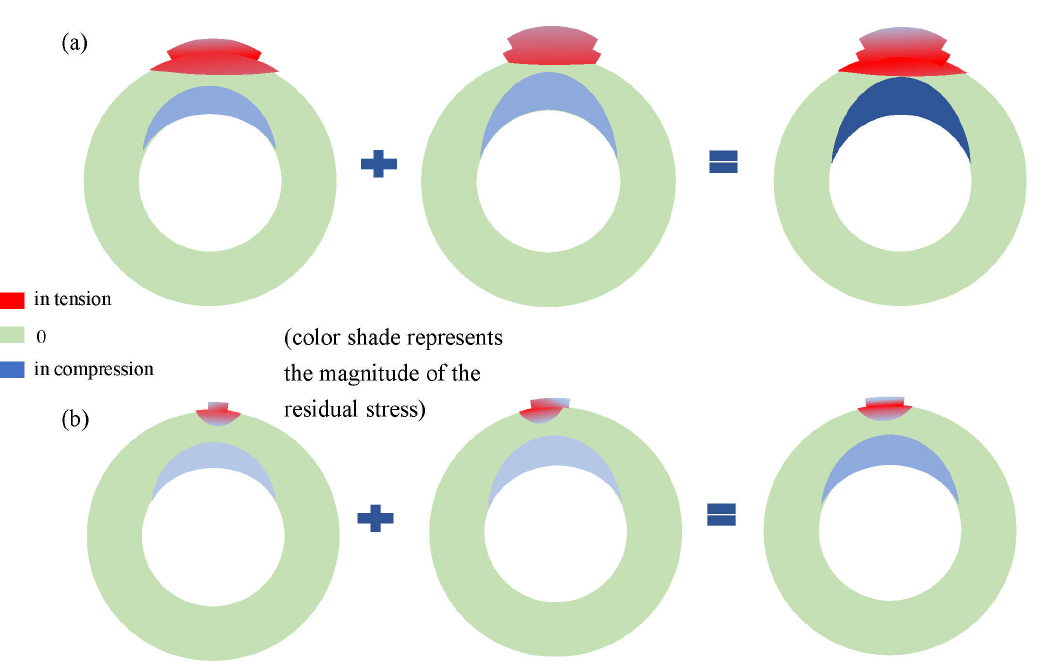
Figure 11. Hoop residual stress distribution at mid-length of the weld overlay joint with center-to-outside welding se- quence for ( a ) 1 layer, ( b ) 2 layers, and ( c ) 3 layers, respectively, ( d ) distribution of hoop residual stress in the through- thickness direction, and ( e ) evolution of the decomposed components of hoop residual stress distribution.